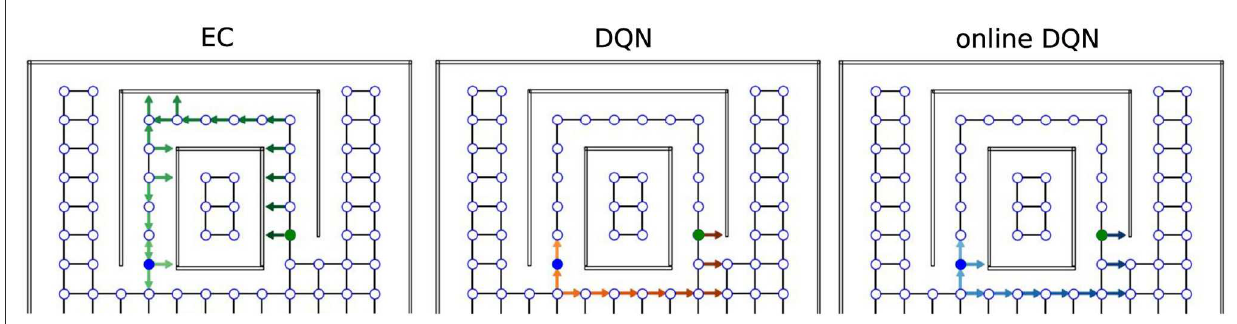
FIGURE6 Sample trajectories in the tunnel maze for three learning algorithms. An arrow is attached to each node that the agent visits in one test trial. The direction of the arrow indicates the orientation of the agent, not the chosen action; lighter colors represent visits earlier in the trajectory and darker colors later in the trajectory. The starting and goal node are depicted in blue and green, respectively.